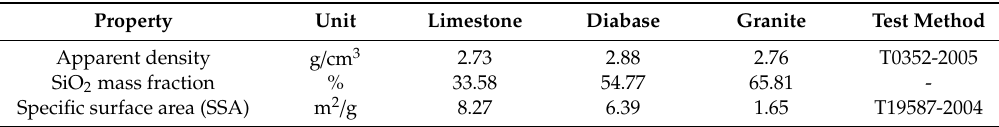
Table 2. Properties of mineral